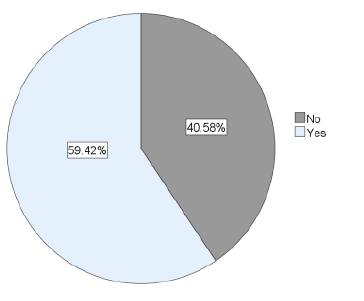
Figure 4: Capacity Building takes into consideration the ability to understand and retain information